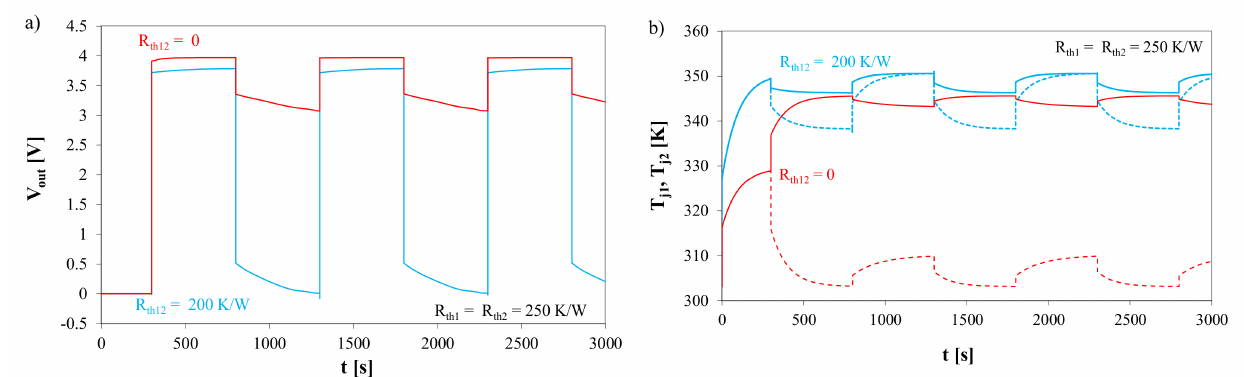
Figure 18. Waveforms of the output voltage ( a ) and the junction temperature ( b ) in the differential pair with thermal couplings taken into